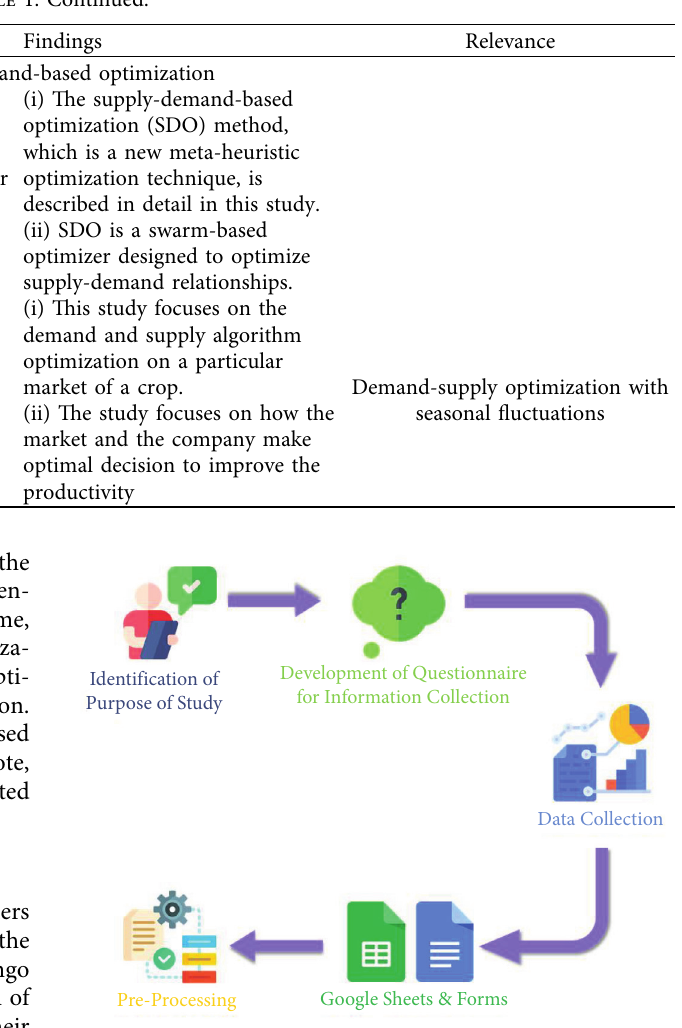
Figure 1: Data collection process